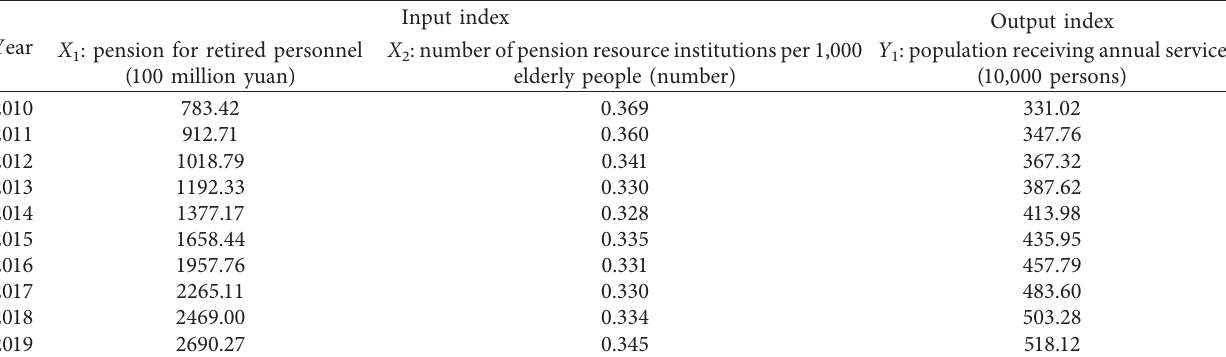
Table 1: Evaluation index of the efficiency of pension resources allocation.